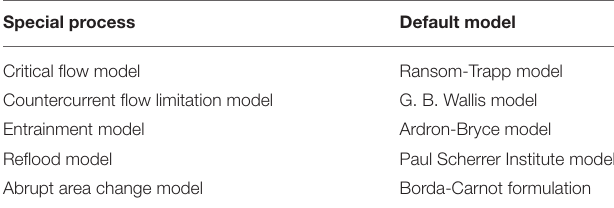
TABLE 2 | Summary of specific models developed for LOCUST (China Nuclear Power Technology Research Institute, 2019